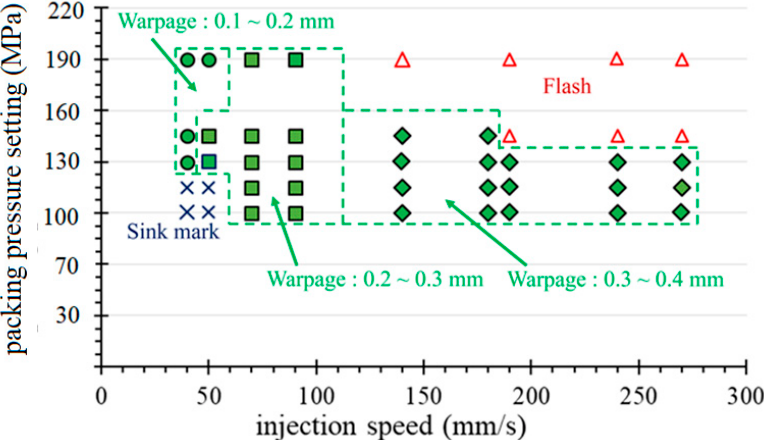
Figure 13. The warpage quality contour of the molded part corresponding to the injection speed and the packing pressure settings.